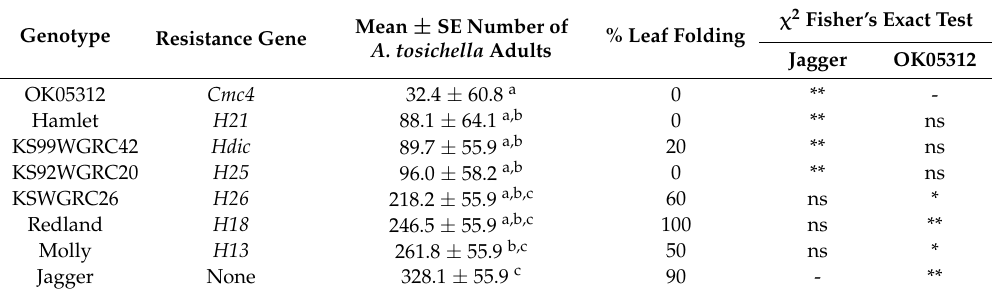
Table 3. Mean ± SE number A. tosichella biotype 1 and A. tosichella —induced folding in plants of M. destructor resistant cultivars, the resistant control OK05312 and the susceptible control Jagger at 7 d post-infestation in a choice test.